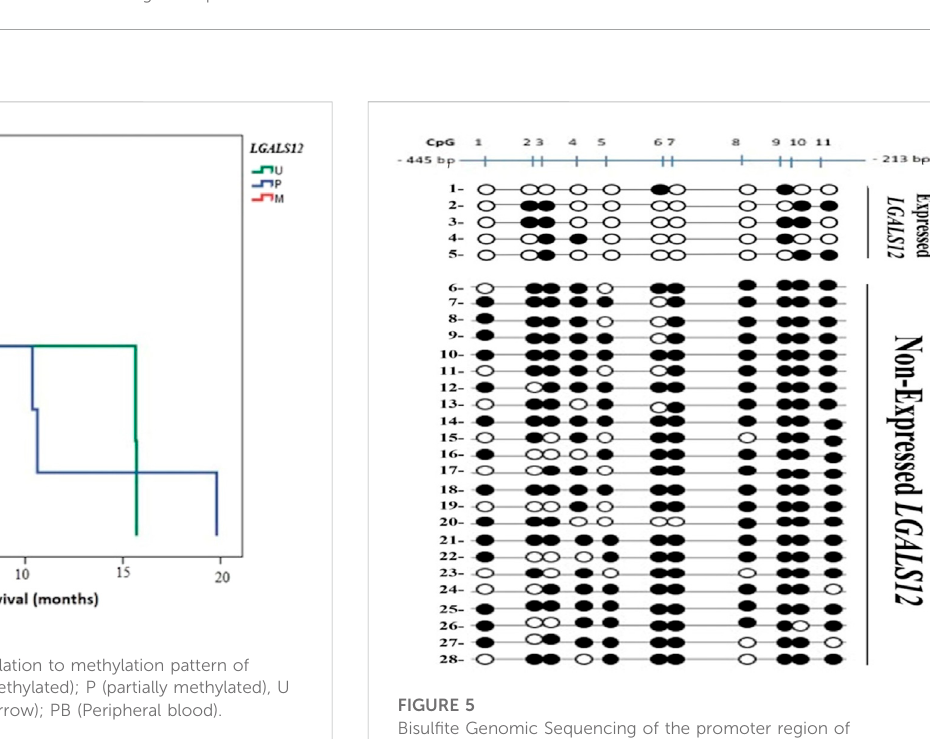
FIGURE 3 Log2 fold change of the LGALS12 gene expression associated with the methylation pattern of its promoter region. Abbreviations: M (methylated); P (partially methylated), U (unmethylated), BM (Bone marrow); PB (Peripheral blood). (A) Box plot showing Log2 fold change of the LGALS12 gene expression associated with the methylation pattern of its promoter region in PB; the X-axis represents the methylation pattern of LGALS12 gene and the Y-axis shows Log2 fold change of the LGALS12 gene expression in PB cohort. (B) Box plot showing Log2 fold change of the LGALS12 gene expression associated with the methylation pattern of its promoter region in BM; the X-axis represents the methylation pattern of LGALS12 gene and the Y-axis shows Log2 fold change of the LGALS12 gene expression in BM cohort.